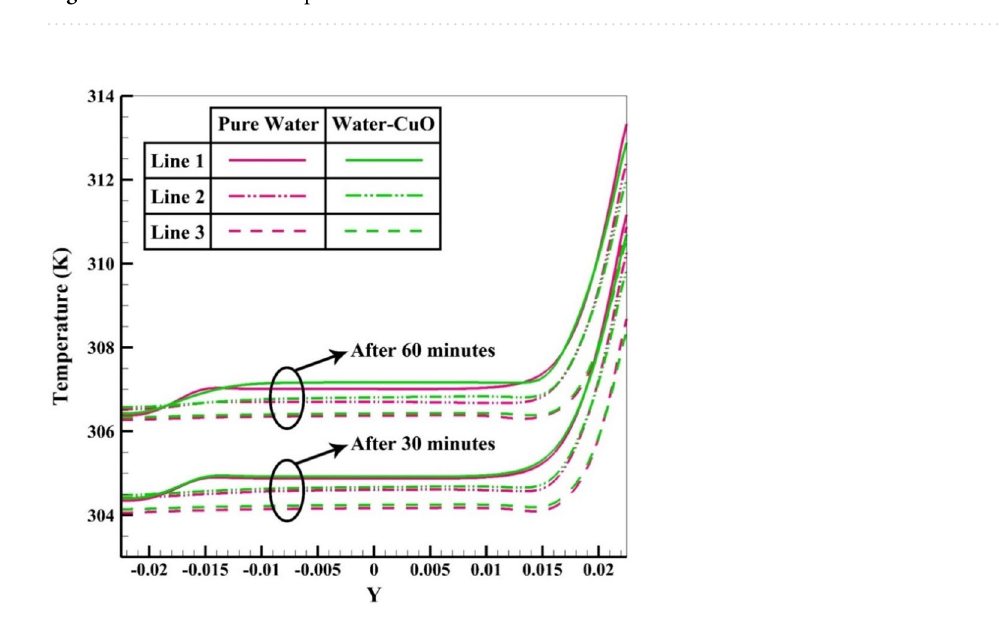
Figure 10. Distribution of temperature at various